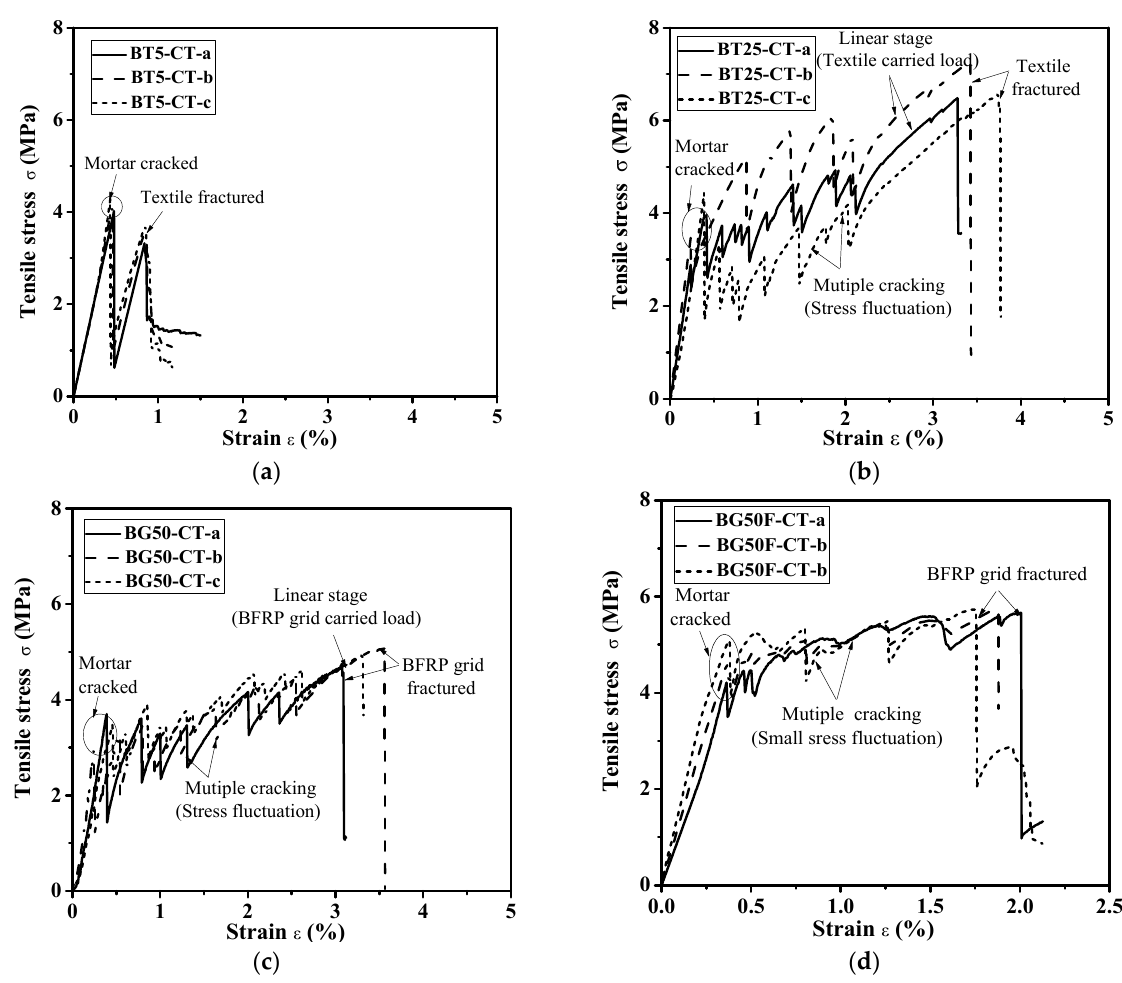
Figure 7. Tensile stress–strain curves of the BGRM before exposure to elevated temperature: ( a ) BT5- CT; ( b ) BT25-CT; ( c ) BG50-CT; ( d ) BG50-CT.